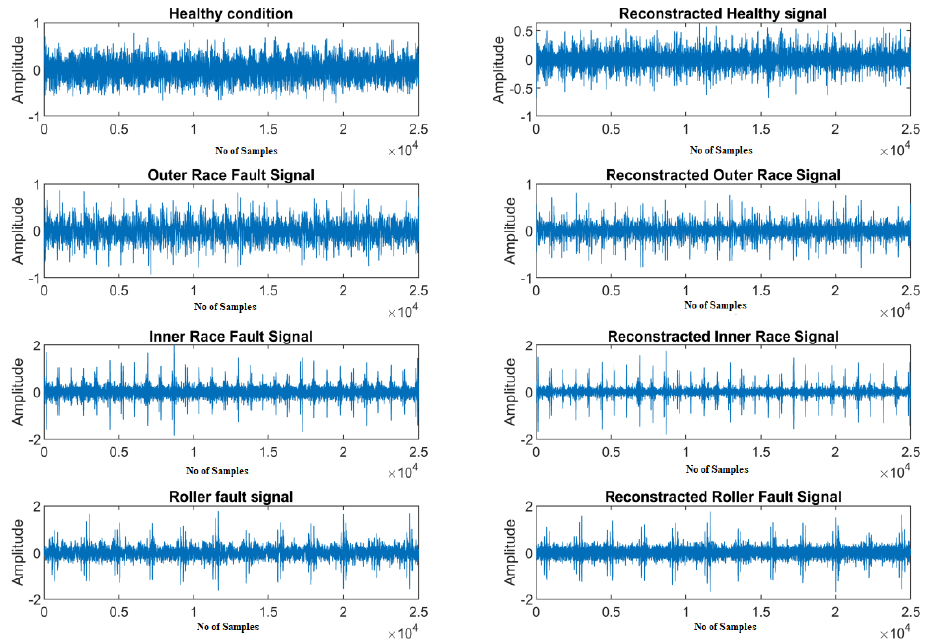
Figure 7. Original and reconstructed signals after IMF selection based on kurtosis.